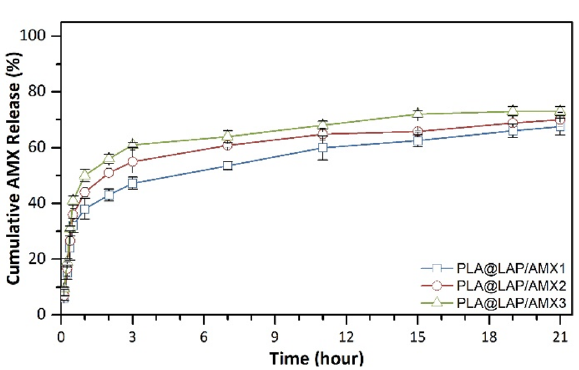
Figure 4. In vitro release of AMX from scaffolds in PBS (1X or 0.01 M, pH 7.4) at 37